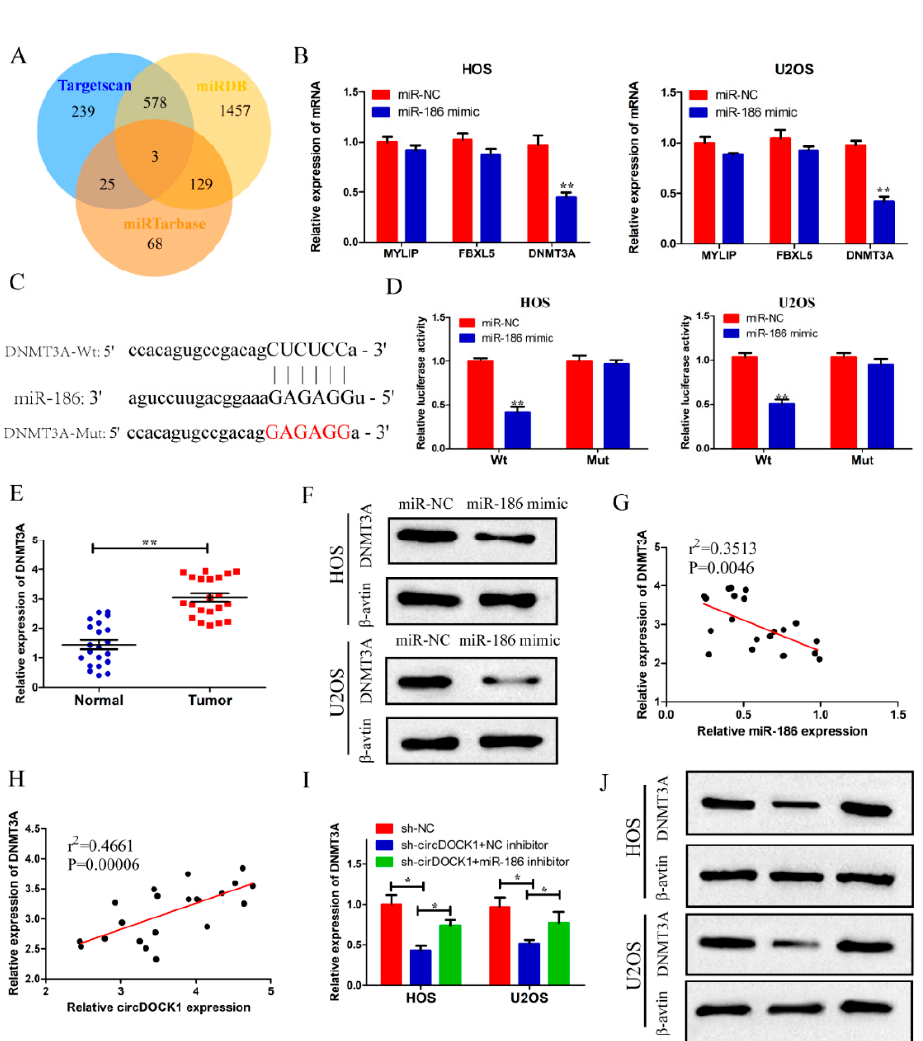
Figure 5. CircDOCK1 upregulated DNMT3A expression via sponging miR-186. ( A ) Bioinformatics analysis outcomes predicting the potential miR-186 target genes. ( B ) The expressions of four target genes were reduced after transfection with miR-186 mimics. ( C ) The miR-186–DNMT3A binding sites were predicted using bioinformatics, and the red sequence means mutant binding sequences. ( D ) Luciferase reporter assay-based validation concerning the correlation of DNMT3A with miR-186. ( E ) DNMT3A expression was high in OS tissues. ( F ) MiR-186 significantly decreased DNMT3A protein levels. ( G ) Expression of DNMT3A was negatively associated with miR-186. ( H ) DNMT3A level was positively associated with circDOCK1. ( I , J ) After co-transfection, qRT-PCR combined with Western blotting was employed to assay the protein and mRNA levels of DNMT3A. * p < 0.05, ** p <